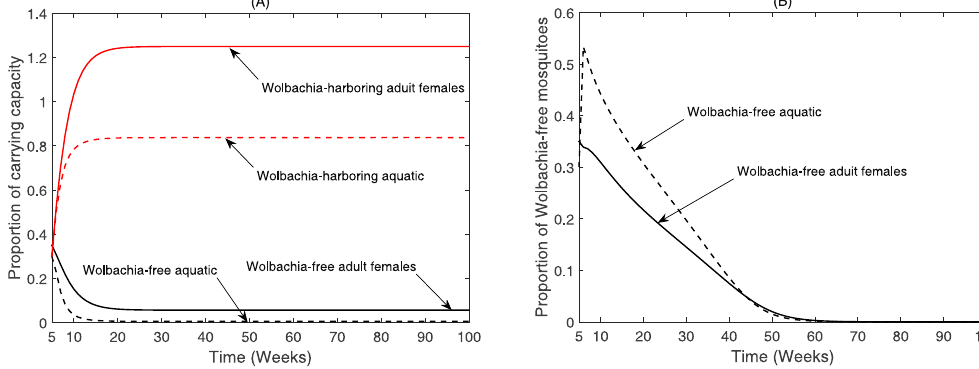
Figure 6. Numerical comparison with both aquatic and adult female mosquitoes. The change of ratio of mosquitoes after ( A ) simultaneously releasing Wolbachia-harboring female and male mosquitoes ( Λ F = 0.3),